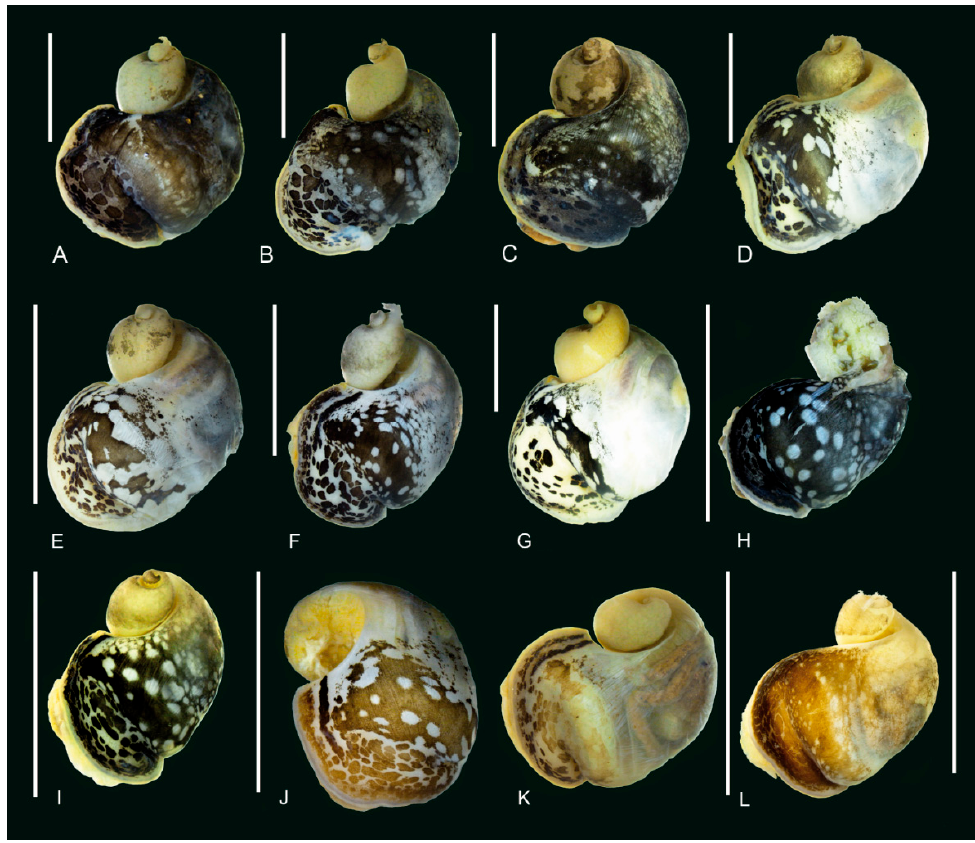
Figure 7. Variability in mantle pigmentation of Radix auricularia from Lake Baikal. ( A ) North of Buguldeyka, 2–3 m depth ( Radix Baikal 2); ( B ) North of Buguldeyka, 2–3 m depth ( Radix Baikal 1);